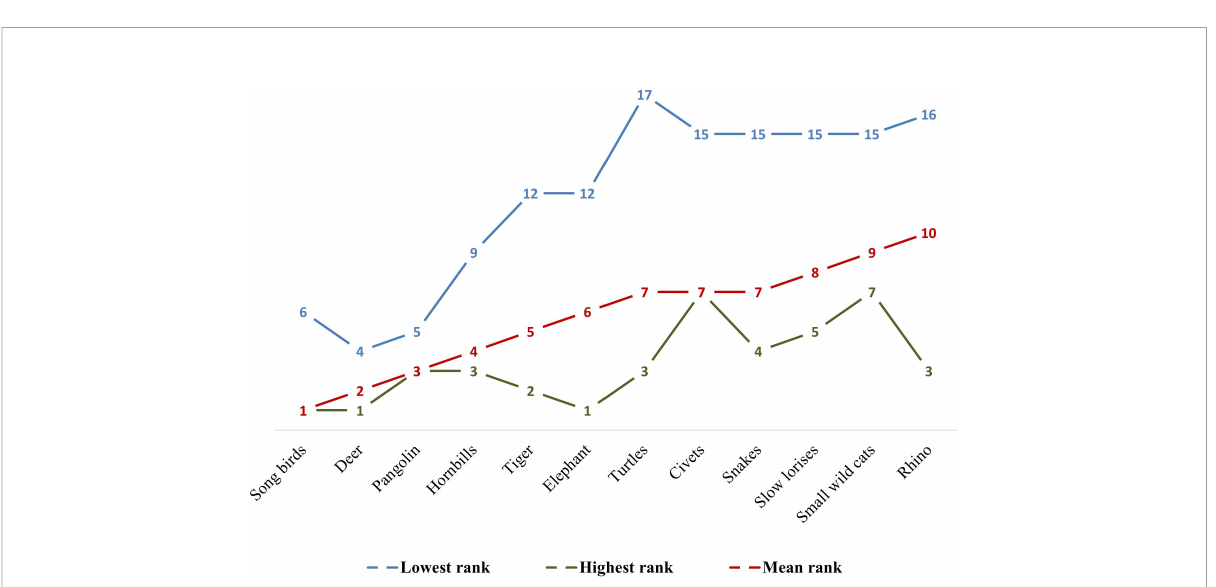
FIGURE 4 Top ten of the most commonly targeted species by poachers in Bukit Barisan Selatan National Park according to the ranking of focus group participants (N=27) (see S2 for full species list). Focus group participants were broken into fi ve subgroups and the lowest rank (blue), highest rank (green) and the compiled or mean rank (red) given by subgroups is displayed for each wildlife genera or